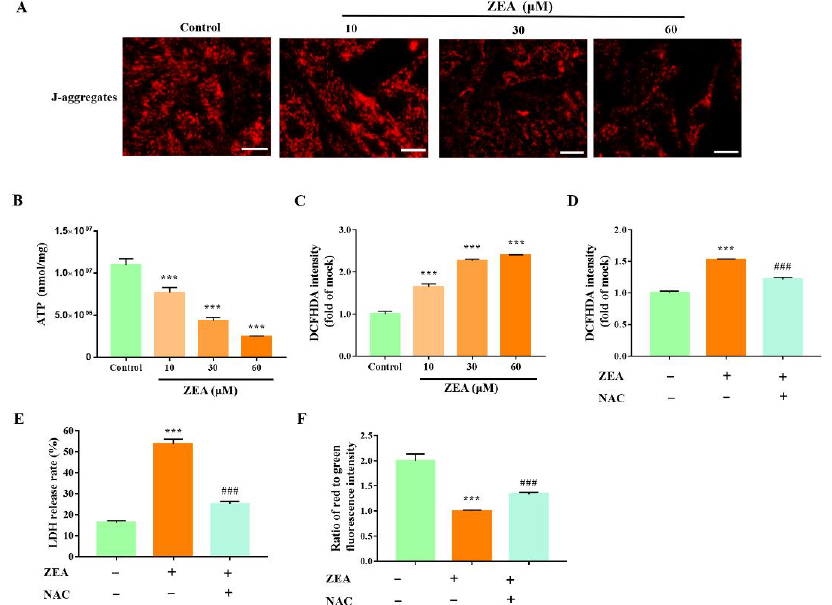
Figure 3. ZEA induces ROS-mediated mitochondrial dysfunction in gESCs. A-C Cells were treated with ZEA at the indicated concentrations (10, 30, and 60 µ M) for 24 h. ( A ) Mitochondrial membrane potential was visualized using a probe for J-aggregates. Scale bar, 20 µ m ( B ) The ATP content was detected using an ATP assay kit. ( C ) ROS production in ZEA-treated cells was evaluated by fluorescence analysis of DCFH-DA. D-G Cells were pre-incubated with the ROS scavenger NAC (50 µ M) for 2 h before treatment with ZEA (60 µ M) for 24 h. ( D ) The ROS generation was evaluated by fluorescence analysis of ROS-DCFH-DA. ( E ) LDH release was assessed using a cytotoxicity LDH assay kit. ( F ) Mitochondrial membrane potential was assessed by fluorescence analysis of JC-1 staining. *** p < 0.001 vs. control group. ### p < 0.001 vs. ZEA group.